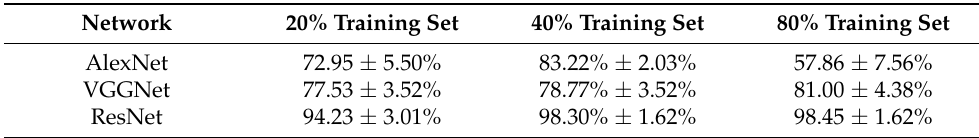
Table 6. Accuracy results for the data generated by our approach (64 ×